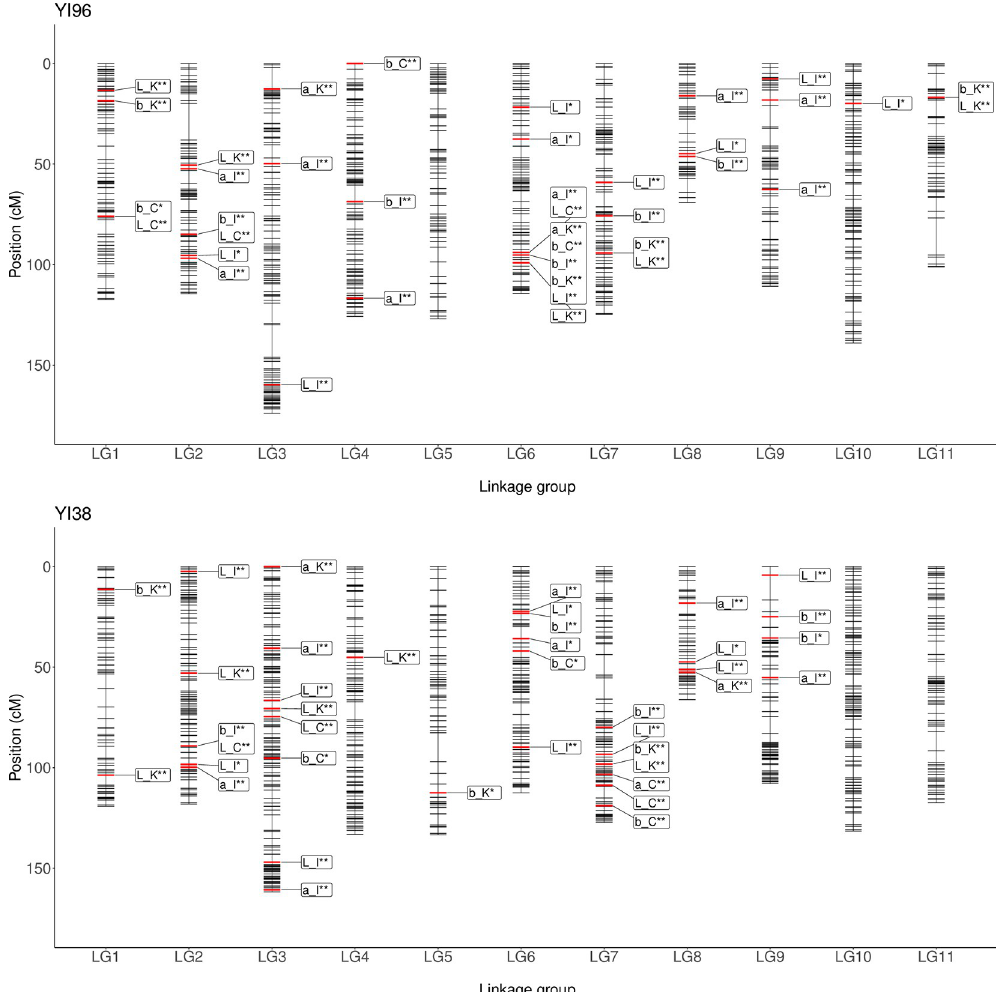
Fig 3. Linkage maps with QTLs of heartwood color traits ( L � , a � , and b � ). Short horizontal bars represent the position of the markers, and the red horizontal bars represent QTLs. QTLs were labeled using trait_site. Abbreviations: L, L � ; a, a � ; b, b � ; I, Ibaraki; C, Chiba; K, Kumamoto. Level of significance of QTLs: �� , 95% CI; � , 80% CI.